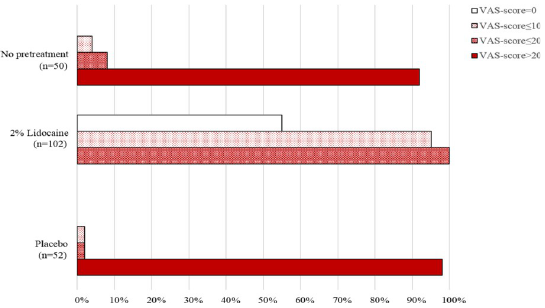
Fig 5. The bar chart shows the distribution of subjects between the groups ranked by VAS-score for the cases of the injection of 100 μ L of 2% lidocaine or placebo prior to cannulation, or cannulation without any pretreatment. Thus, the non-shaded bar, slightly shaded bar, moderately shaded bar and entirely shaded red bar represents the percentage of subjects related to the groups: VAS-score = 0, VAS-score � 10, VAS-score � 20, VAS-score > 20, respectively.